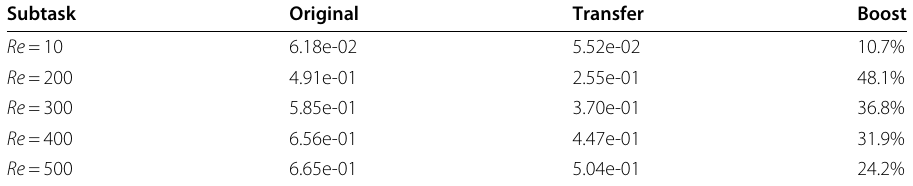
Table 5 Performance boost of PINN-anneal on the Navier-Stokes equations using transfer learning Subtask